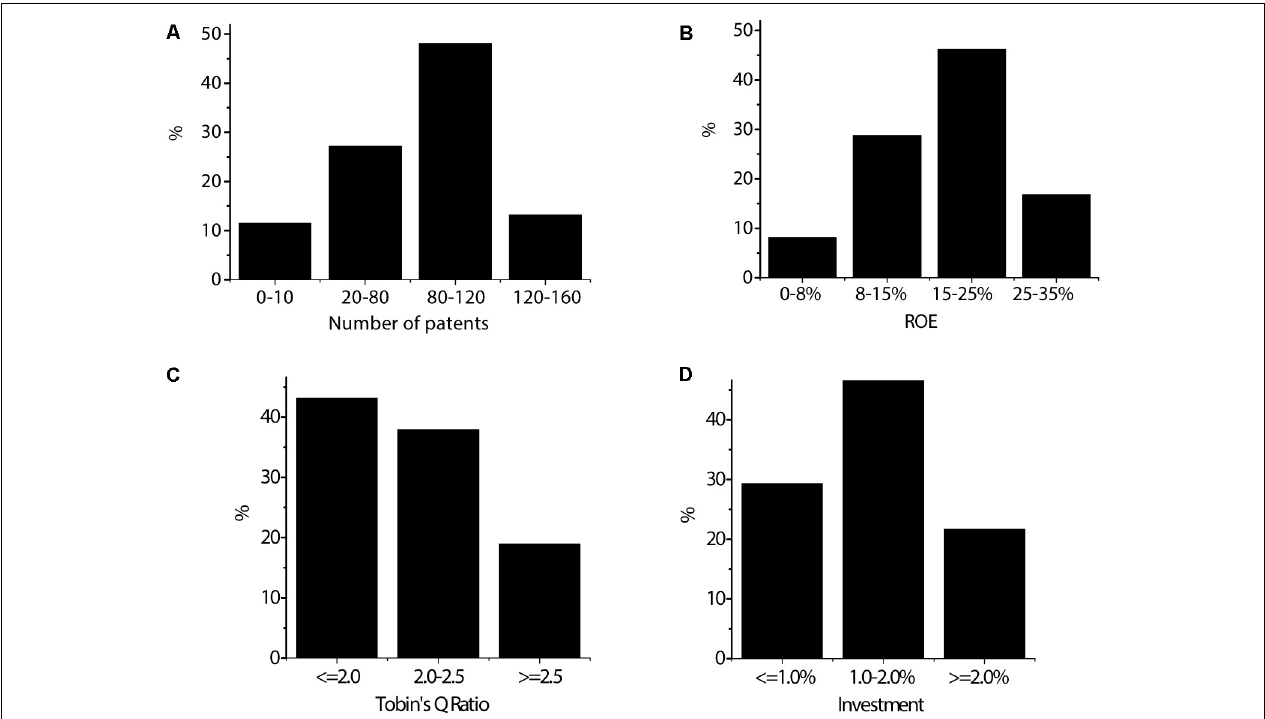
FIGURE 3 | Distribution of the selected exchanges of listed enterprises. (A) The number of patents of the invested enterprise. (B) The return on equity of the invested enterprise. (C) The Tobin’s Q ratio of the invested enterprise. (D) The proportion of R&D investment of the invested enterprise.